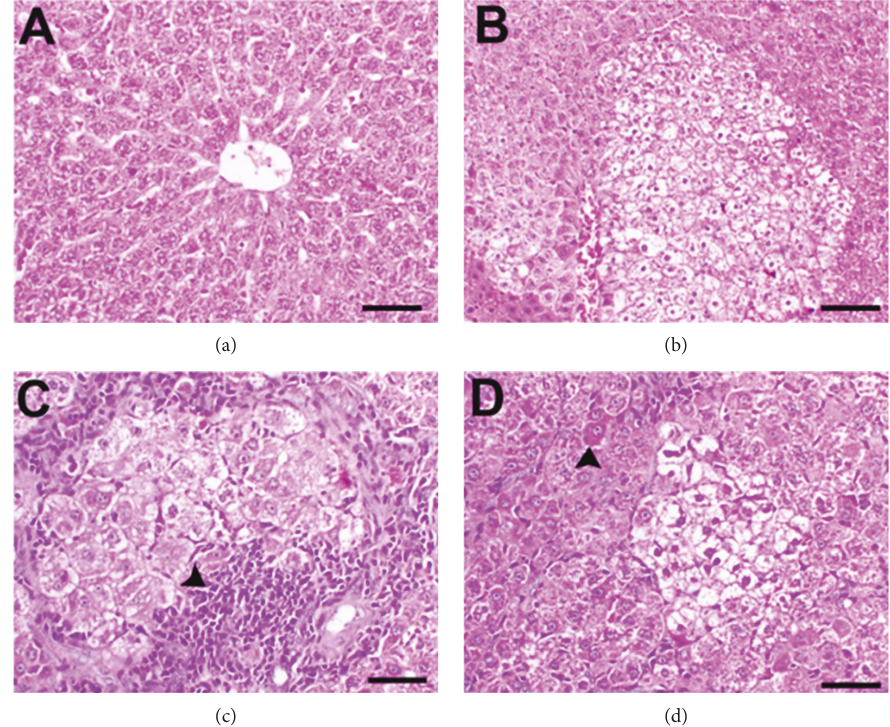
Figure 5: Photomicrographs of H&E-stained liver sections of the normal group (a), the PBS group (b), the CSC-Ex group (c), and the MSC- Ex group (d). Scale bar: a, b, 50 μ m; c, d, 30 μ